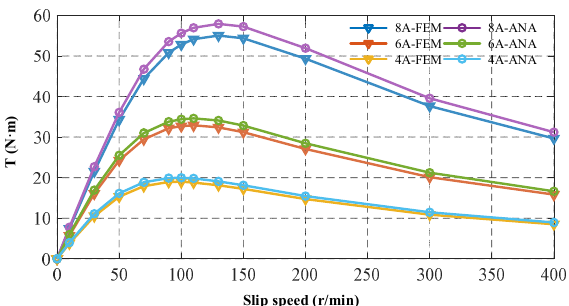
Figure 17. The output torque of HTR-ASD under different slip speed and excitation currents.